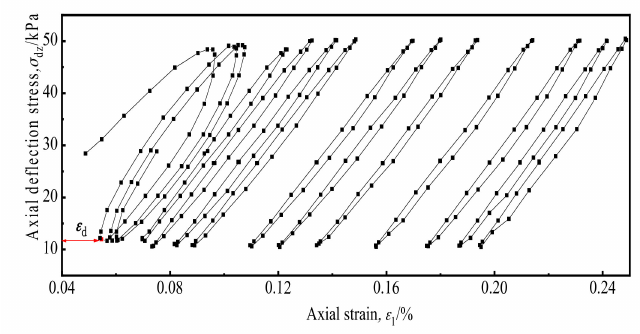
Figure 9. Stress–strain curves of soil under different